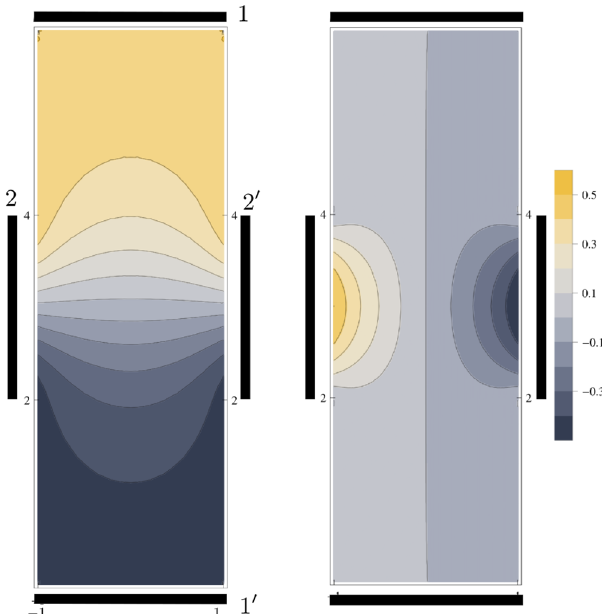
FIG. 8. Two-dimensional plots of the in-phase (left-hand panel) and out-of-phase (right-hand panel) potential fields for a capac- ¼ π = 2 . The itively coupled four-terminal Hall-bar device, for θ H ¼ σ = 2 C frequency of the applied field is ν [Eq. (29)], the first L gy perfect gyration frequency. Contacts span the entire (length ¼ 2 ) ¯ V ¼ (cid:3) 0 of the top and bottom edge of the bar, with . 5 V. The positions of the contacts are indicated with the black bar. Length- ¯ V ¼ 0 2 contacts are centered on the left and right of the bar, with . The capacitance function c ð s Þ is a constant on all the terminal boundaries. Perfect gyration requires that there be current only from the left to the right terminal, and that it is in phase. We see that the in-phase current density (left-hand panel), which follows the potential contours in accordance with the guiding-center principle, does indeed flow smoothly from one contact to the other. Note that these contacts are not equipotentials, as